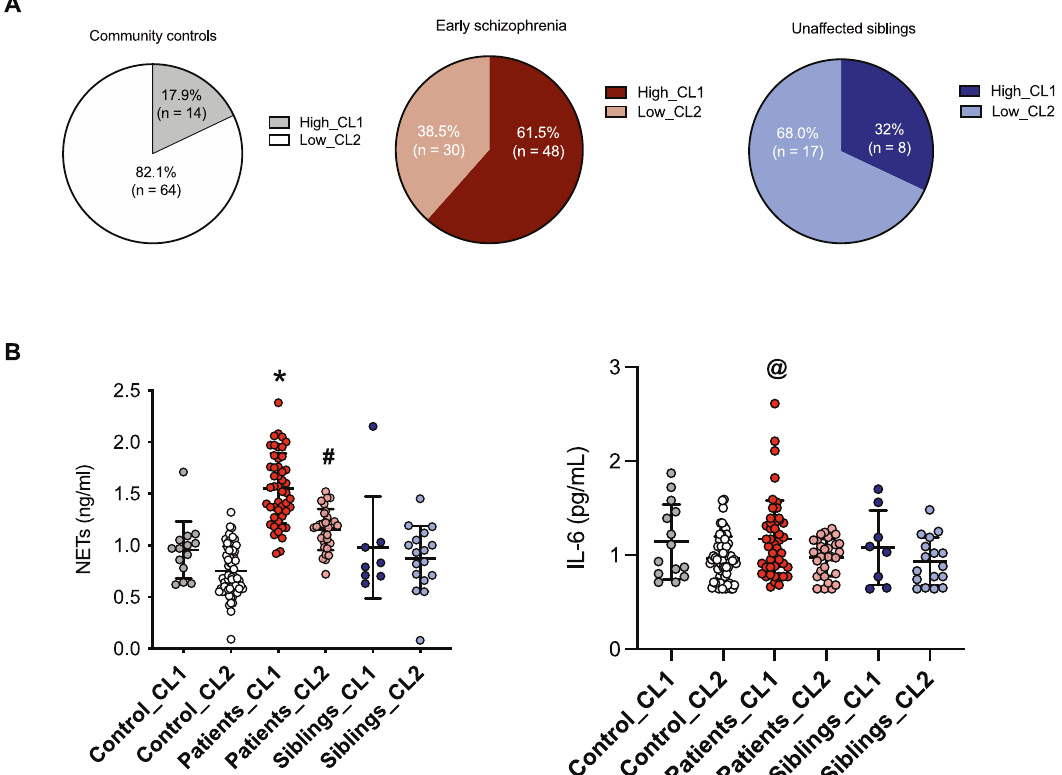
Fig. 4 Distribution of clusters among early schizophrenia patients ( n = 78), their unaffected siblings ( n = 25), and community controls ( n = 78), and subgroup differences in NETs and IL-6 plasma levels. A High (CL1) and low (CL2) clusters were identi fi ed using unsupervised two-step cluster analysis after integrating childhood maltreatment scores, NETs, and IL-6 levels. Cluster 1 (high-CL1) represents participants with higher scores of childhood maltreatment and levels of NETs and IL-6, whereas cluster 2 (low-CL2) represents the opposite. B Clusters subgroups differed signi fi cantly on levels of NETs and IL-6 (one-way analysis of covariance with Bonferroni post-hoc adjusted for sex, tobacco smoking, and other recreational drugs). *Higher NETs in patients high-CL1 vs all the remaining groups ( p < 0.001); #Higher levels of NETs in patients low-CL2 vs controls low-CL2 ( p < 0.001); @Higher levels of IL-6 in patients high-CL1 vs participants in the low-CL2 (patients: p = 0.049; siblings: p = 0.025; controls: p = 0.004). NETs and IL-6 (mean, SD) are represented as natural-log transformed